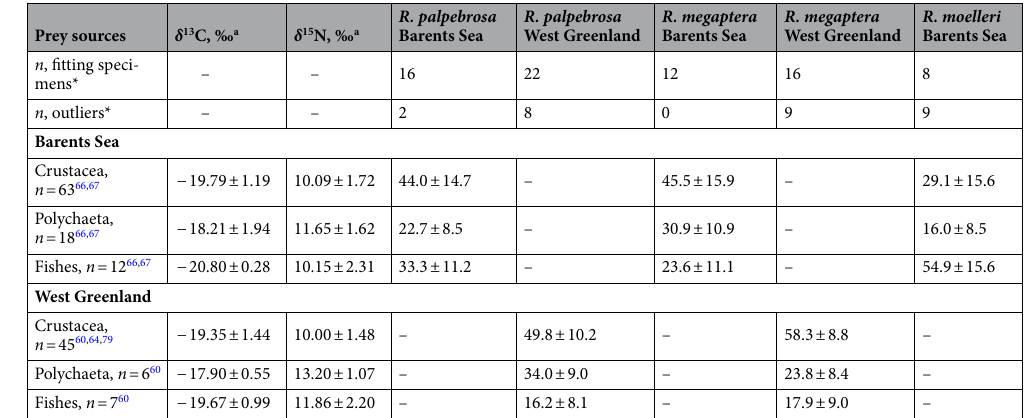
Table 4. Values of δ 13 C and δ 15 N for the prey group sources used in Bayesian mixing model SIMMR 0.4.1, and their predicted relative contribution to the diet in the studied species of the genus Rossia . Values of δ 13 C and δ 15 N and relative contributions are mean ± SD. Significant p -values are in bold. *See “Methods” section for fitting checks. Only the fitting specimens were used. a Significant differences between source values (Kruskal–Wallis H test): Barents Sea, δ 13 C H 2,93 = 25.63, p < 0.0001 (Crustacea–Polychaeta U = 269.5, p = 0.0022 ; Crustacea–Fishes U = 142.5, p = 0.0020 ; Polychaeta–Fishes U = 3.5, p < 0.0001 ); Barents Sea, δ 15 N H 2,93 = 10.92, p = 0.0043 (Crustacea–Polychaeta U = 280, p = 0.0011 ; Crustacea–Fishes U = 329.5, p = 0.49; Polychaeta–Fishes U = 59.5, p = 0.0420 ); West Greenland, δ 13 C H 2,58 = 8.82, p = 0.0121 (Crustacea–Polychaeta U = 41, p = 0.0062 ; Crustacea–Fishes U = 144.5, p = 0.74; Polychaeta–Fishes U = 1, p = 0.0034 ); West Greenland, δ 15 N H 2,58 = 15.39, p = 0.0005 (Crustacea–Polychaeta U = 10, p = 0.0004 ; Crustacea–Fishes U = 15, p = 0.0302 ; Polychaeta–Fishes U = 84, p = 0.0430